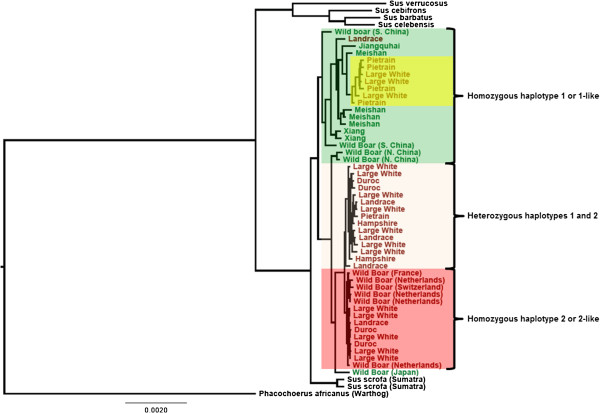
Phylogenetic tree for the haplotypes within the narrowed region in whole genome sequenced animals. Asian animals (green) are homozygous for haplotype 1 or 1-like, whereas European animals (red) have both haplotypes. European cluster of animals within the Asian animals group (yellow) shows that the haplotype 1 (low androstenone) originated from Asian breeds.